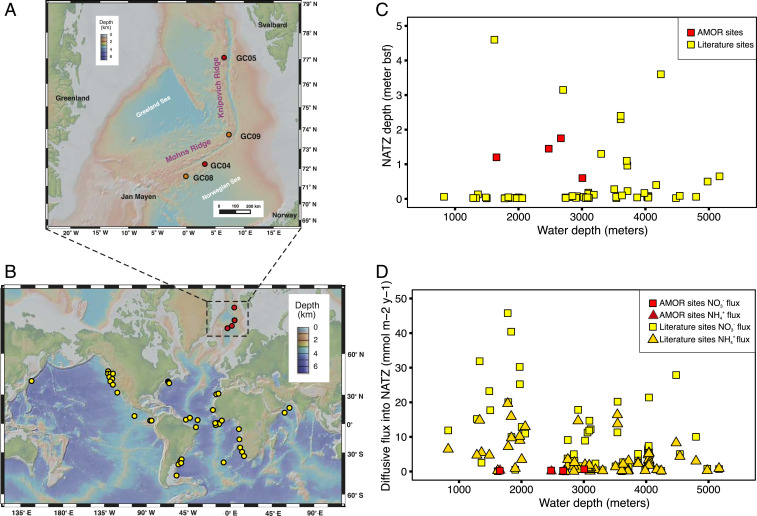
Study sites and global occurrence of NATZ in marine sediments. (A) Bathymetry map of the Arctic Mid-Ocean Ridge in the Norwegian-Greenland Sea. Cores GC08 and GC09 (orange) were sampled during summer 2014. Cores GC04 and GC05 (red) were sampled during summer 2016. (B) Location of marine sediments bearing an observed NATZ, identified based on previously published profiles of nitrate and ammonium. Maps in A and B were created in GeoMapApp version 3.6.10 using the default Global Multi-Resolution Topography Synthesis basemap. (C) Plot of NATZ depth against water depth of sediment locations included in B. (D) Plot of diffusive fluxes of nitrate and ammonium into NATZ against water depths for sediment locations included in B.